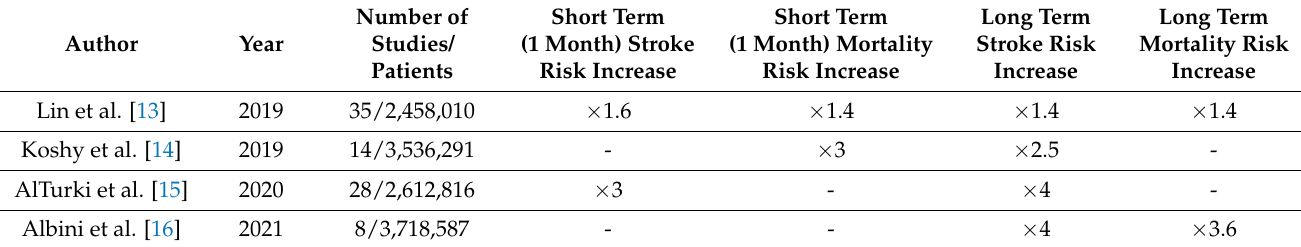
Table 1. POAF related stroke and mortality risk increase in the short and long